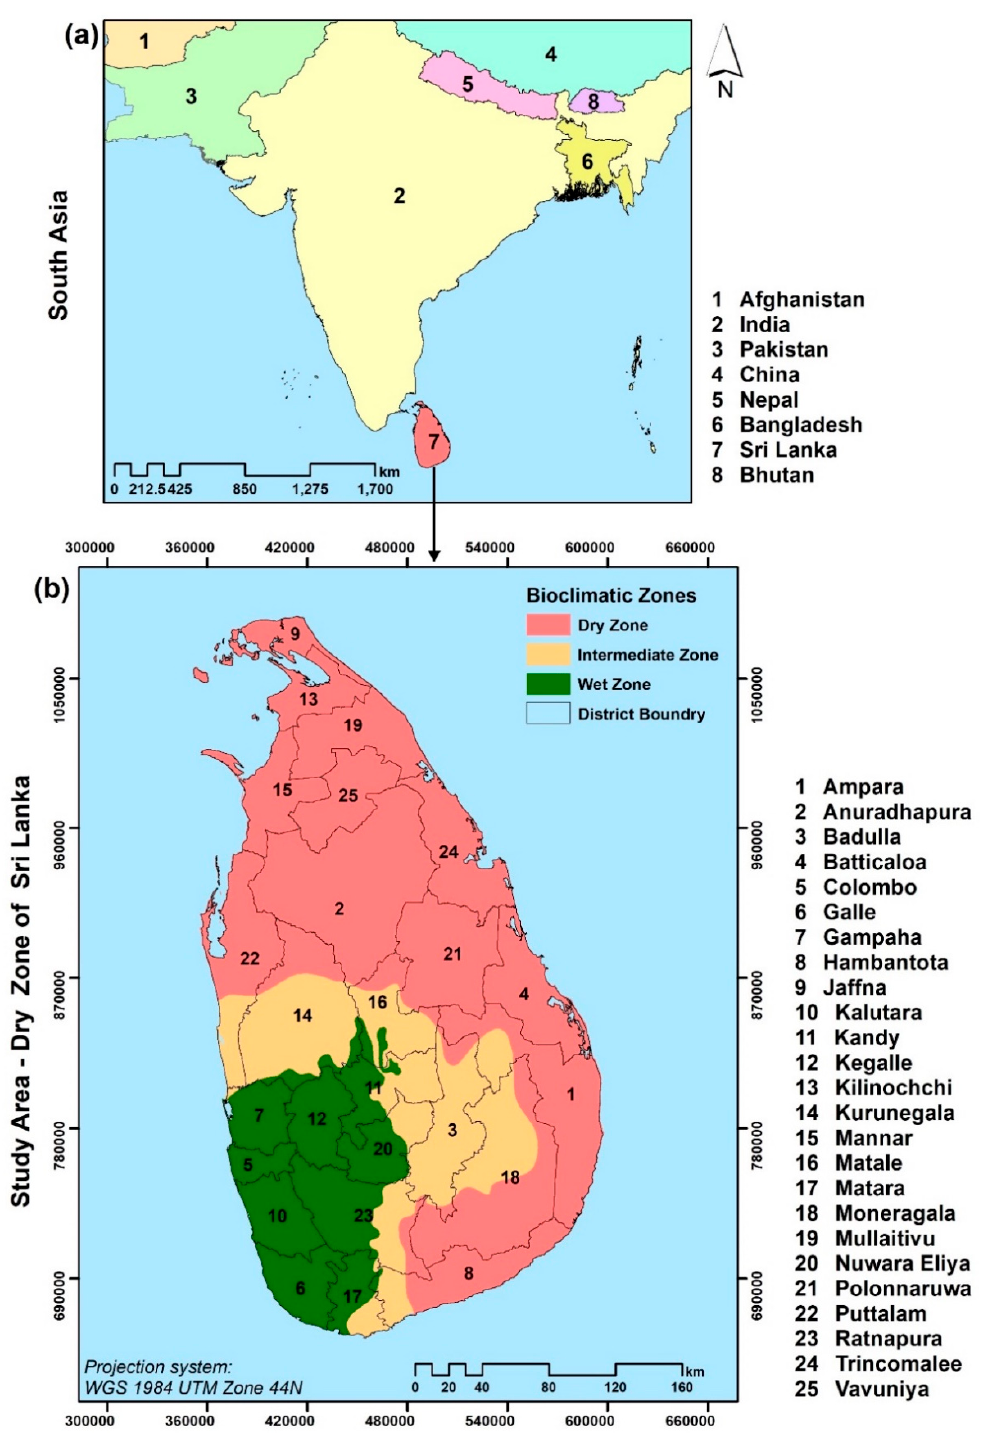
Figure 1. Study area: ( a ) Location of Sri Lanka in South Asia; ( b ) extent of bioclimatic zones in Sri Lanka. The numbered boundaries correspond to 25 administrative districts of Sri Lanka.